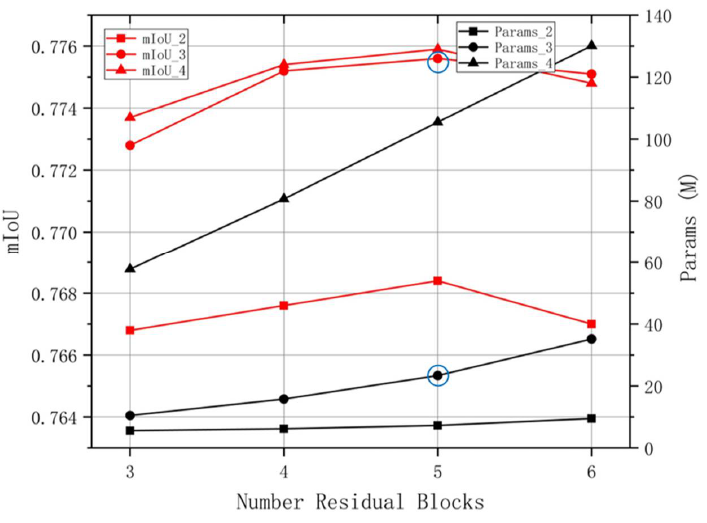
Figure 6. Performance of our MPPNet with different numbers of paths and residual blocks. Red and black lines represent the mIoU result and model params. The rectangle, circle, and triangle patterns on the line represent the number of network paths 2, 3, and 4, respectively. The horizontal axis represents the different number of residual blocks in each extracted block.